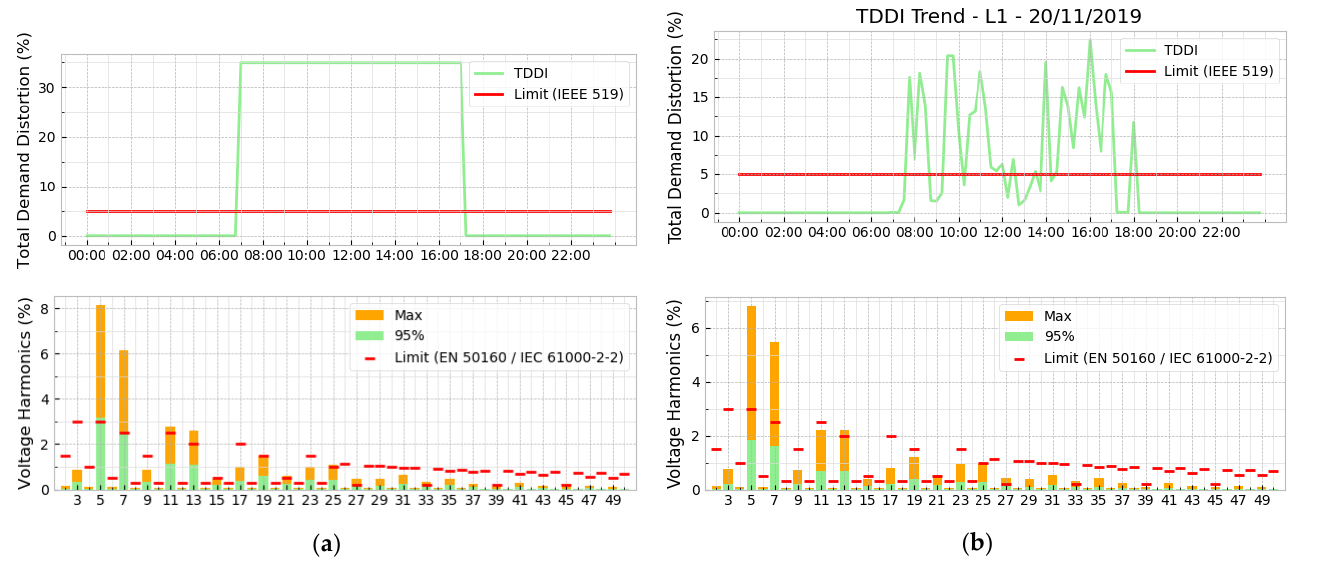
Figure 16. ( a ) Results for the reference case for the industrial machine pool on full utilization during the whole working day. ( b ) Results for the optimized utilization of the machine pool via the Smart DSM algorithm. All machines are connected at a virtual point of common coupling to the grid. The Smart DSM algorithm was allowed short excitations of the normative limits to further enhance the convergence speed. All key indexes showed improvements, pointing towards the Pareto optimal Frontier to maintain a safe grid state in accordance with the normative limits while still ensuring a high utilization.